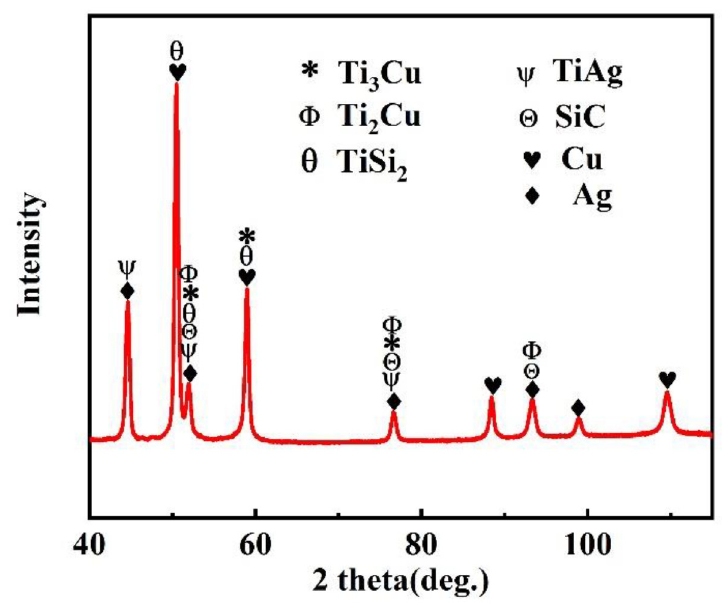
Figure 6. XRD pattern of fracture. Combined with XRD analysis, EDS point scanning analysis results and the binary Ti 3 SiC 2 ceramic were TiC X , Ti X Cu, and Ti X Si Y . Therefore, the reaction products in region II were mainly Ti 5 Si 3 , Ti 2 Cu, Ti 3 Cu, and TiC. According to the results of EDS point scanning analysis, the gray-white network structure (point C) mainly contained Ag and Cu atoms with an atomic ratio of about 1.9:1. Combined with the binary alloy phase diagram, it is believed that the gray-white network structure was Ag-Cu eutectic. With the holding time increasing, the erosion of pure copper and copper mesh generated a large amount of Cu atoms in the interface. In addition, the intermetallic compounds formed by the interfacial reaction such as Ti 5 Si 3 , TiC, Ti 2 Cu, and Ti 3 Cu prevented the diffusion of Cu as well as Ag